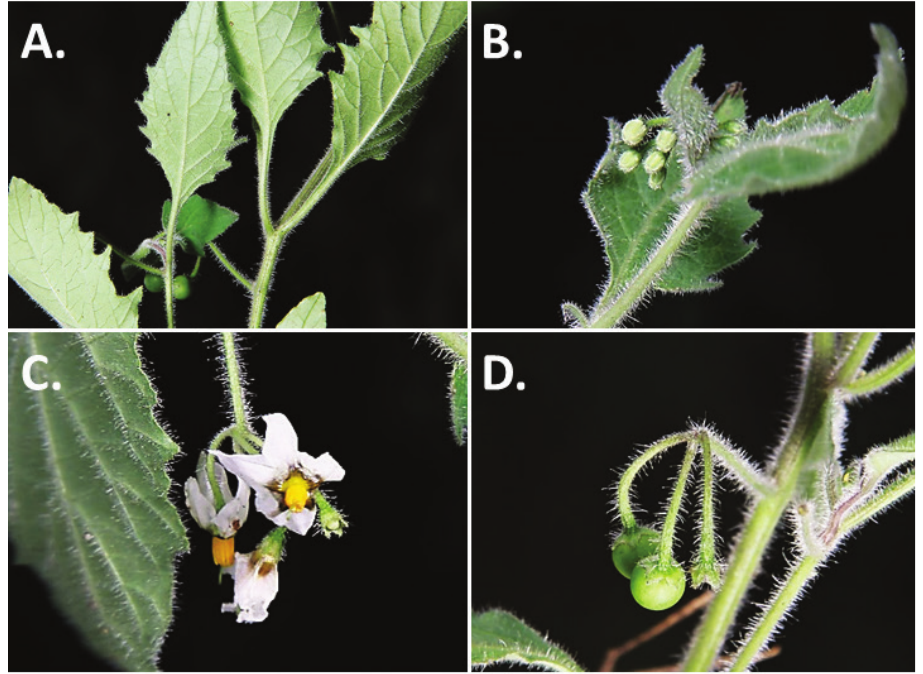
Figure 37. Solanum pruinosum Dunal. A Leaves B young branch with flowering buds C inflorescence with flowers at full anthesis D developing fruits ( A–D Amith JDA-30248 ). Photos by M. Gorostiza